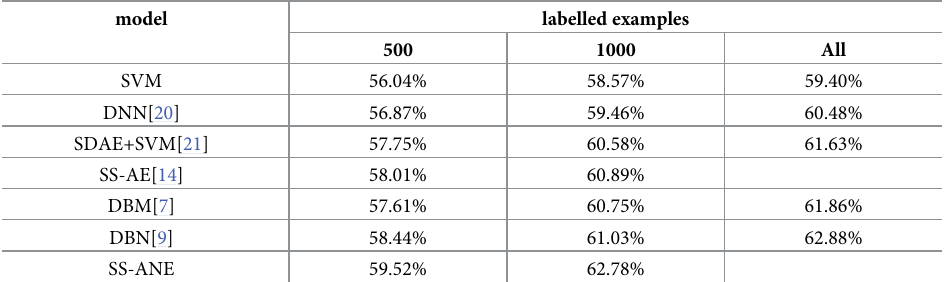
Table 3. Average accuracy rate on the CSC test set with 500,1000 labelled examples.